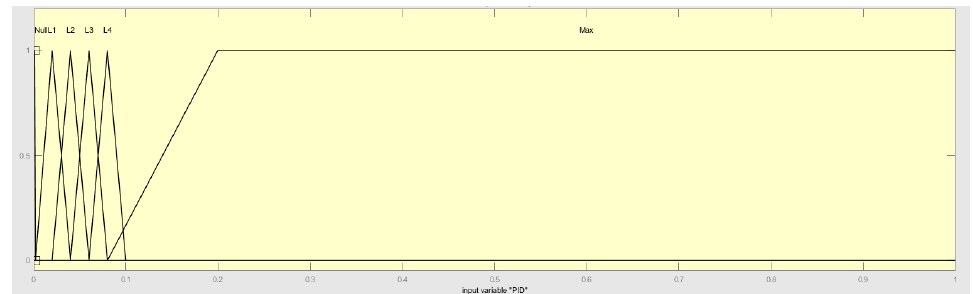
Figure 8. Membership functions of the pitch reference input calculated by the improved PI.